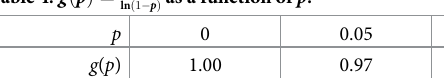
Table 4. g ð p Þ ¼ (cid:0) p